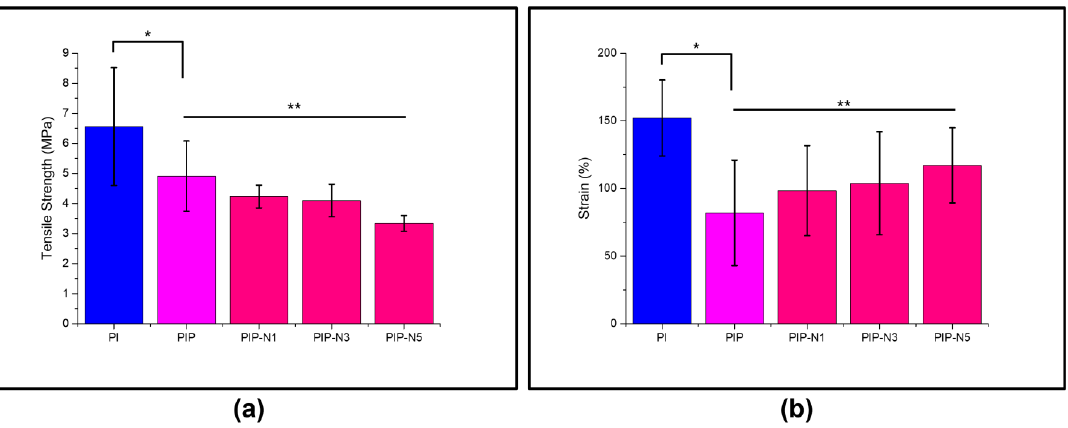
Figure 10. Mechanical performance of prepared films: ( a ) tensile strength (n = 5; mean ± SD, * p < 0.0001, R 2 0.82, ** p < 0.0012, R 2 0.70); ( b ) strain (n = 5; mean ± SD, * p < 0.014, R2 0.57, ** p < 0.01, R 2 0.48).